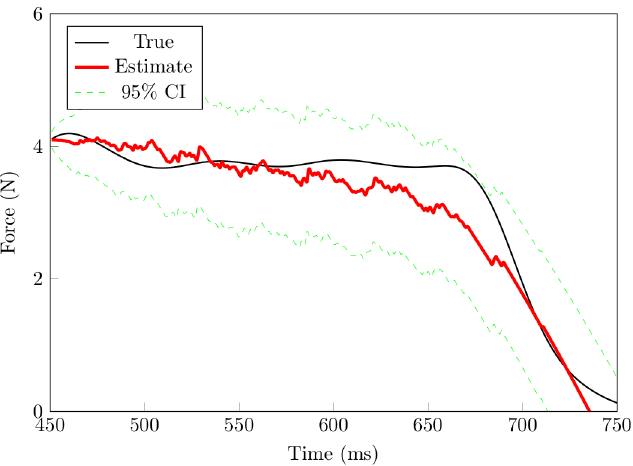
Fig 5. Recursive decoding results based on subset of the data not seen by the encoding model. In this scheme, the first portion of the data, as described in the Methods section, was used to map the relationship between the force profiles and the corresponding SA-I afferent spike activity (encoding). Then using parameters estimated from the encoding stage and the rest of the SA-I afferent data, the force stimulus is predicted. Here we use all 28 SA-I afferents to decode and results show that the algorithms generalize well. The performance of the filter is less accurate during the off-loading phase (period just before contact at the finger-pad is lost) when compared to that during the plateau phase. It is likely because SA-I afferents do not respond during this period (and at point just when contact is made). The model, for example at the on-loading phase may not have sufficient information due to latency. It is also possible that decoding would improve if we consider other types of afferents like the FA-II because they are the most sensitive.